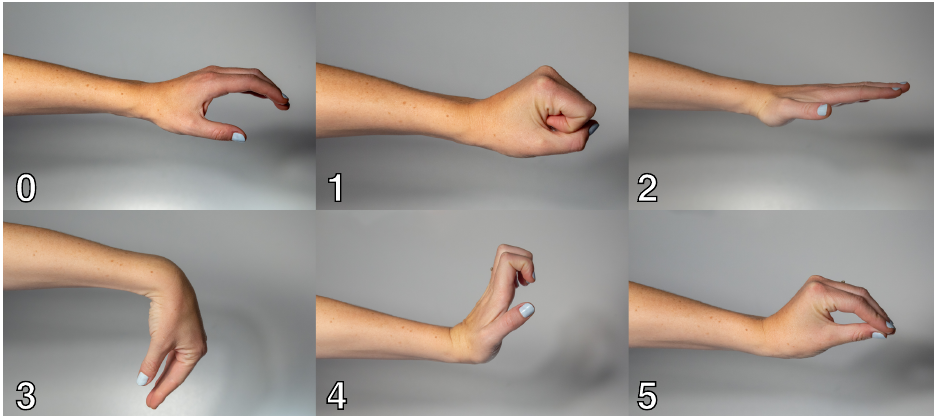
Figure 6. The six classes: rest, fist, hand extension, wrist flexion, wrist extension and pinch grasp.